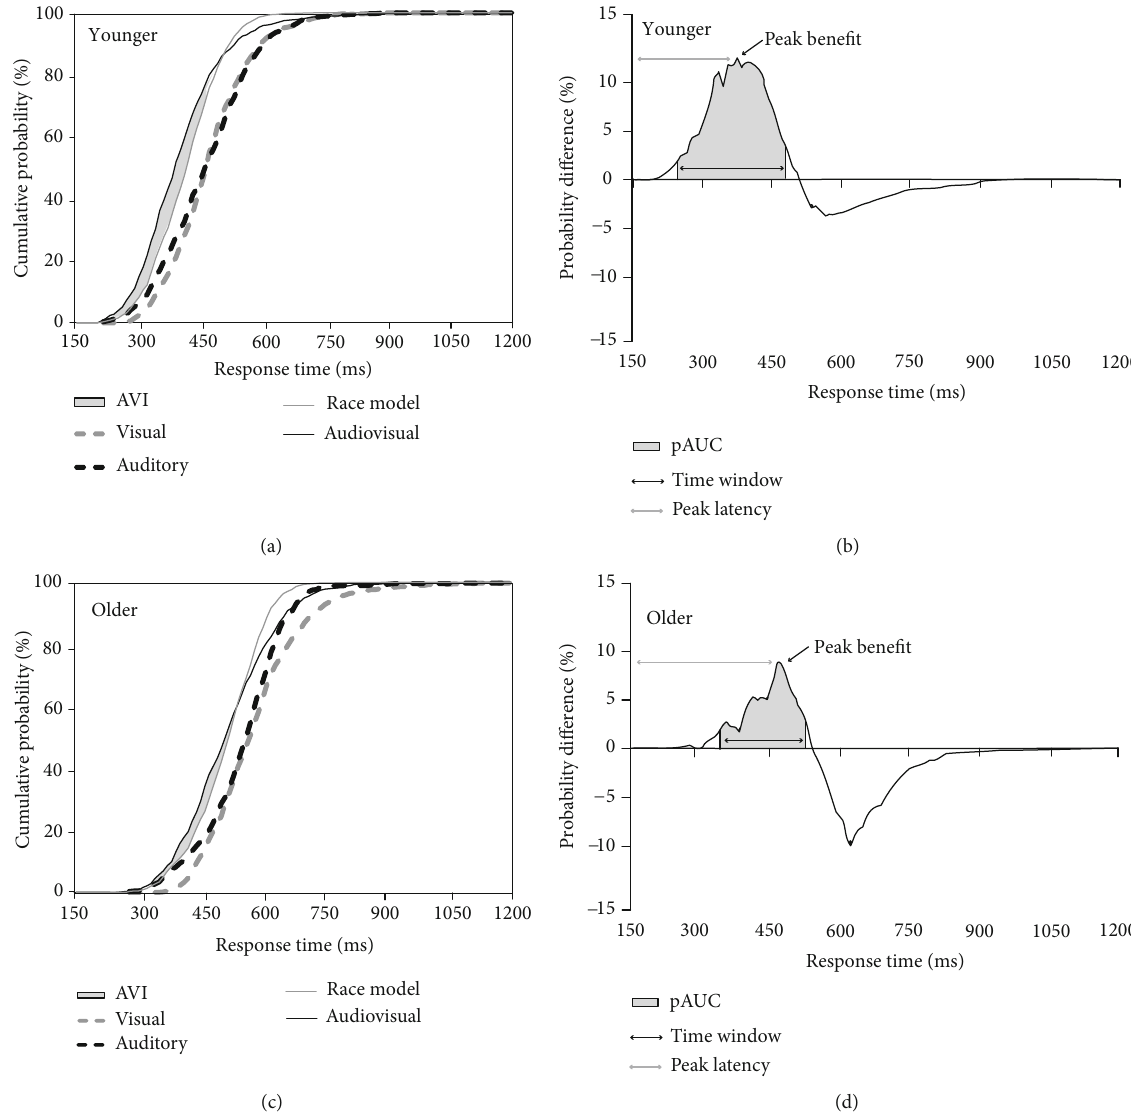
Figure 2: Cumulative distribution functions (CDFs) for the discrimination response times to auditory, visual, and audiovisual stimuli and the race model in (a) younger adults and (c) older adults. Probability di ff erence between audiovisual CDFs and race model CDFs in (b) younger adults and (d) older